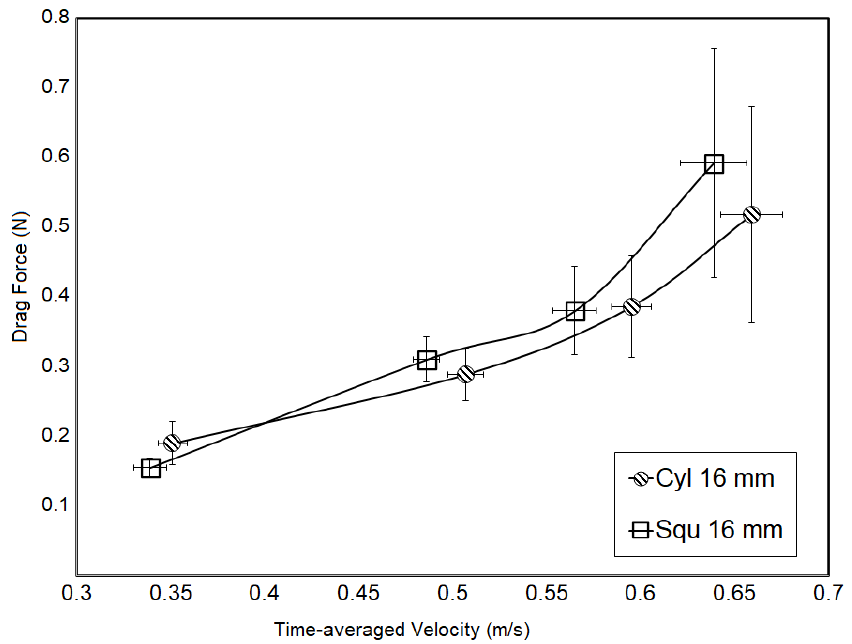
Figure 18. The mean velocity vs. mean force shows monotonic increase in the drag force with the increase in applied velocity. Error bars show standard deviations that increase with the velocity. The errors from the flow meter are relatively smaller compared to that from the force